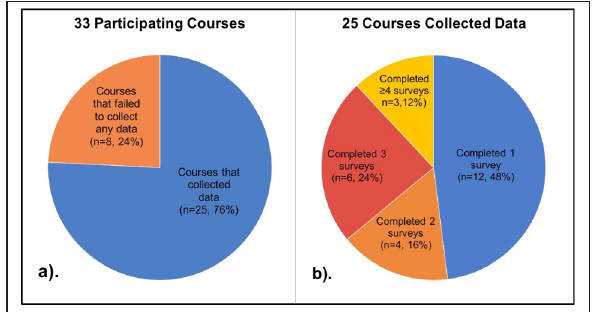
Figure 2: We considered any course that brought Clark’s Nutcracker Project materials into the field as “participat- ing” (a) . Courses that succeeded in collecting data in the field completed between one and five surveys (b)